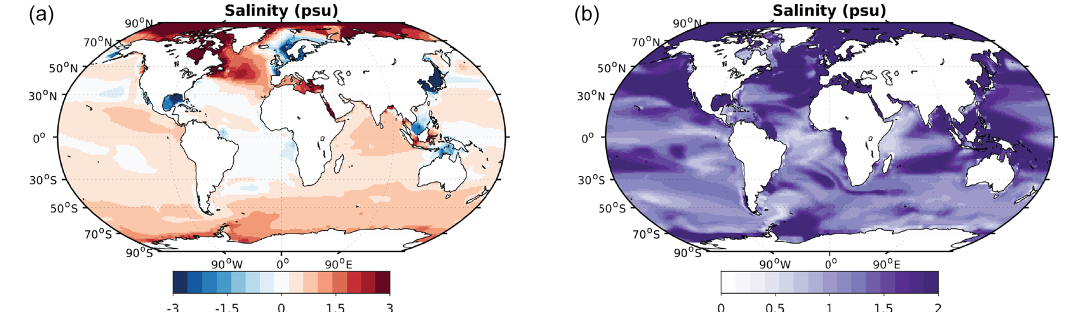
Figure 8. Annual mean sea surface salinity lgm–piControl anomaly (a) and model spread (b) (in